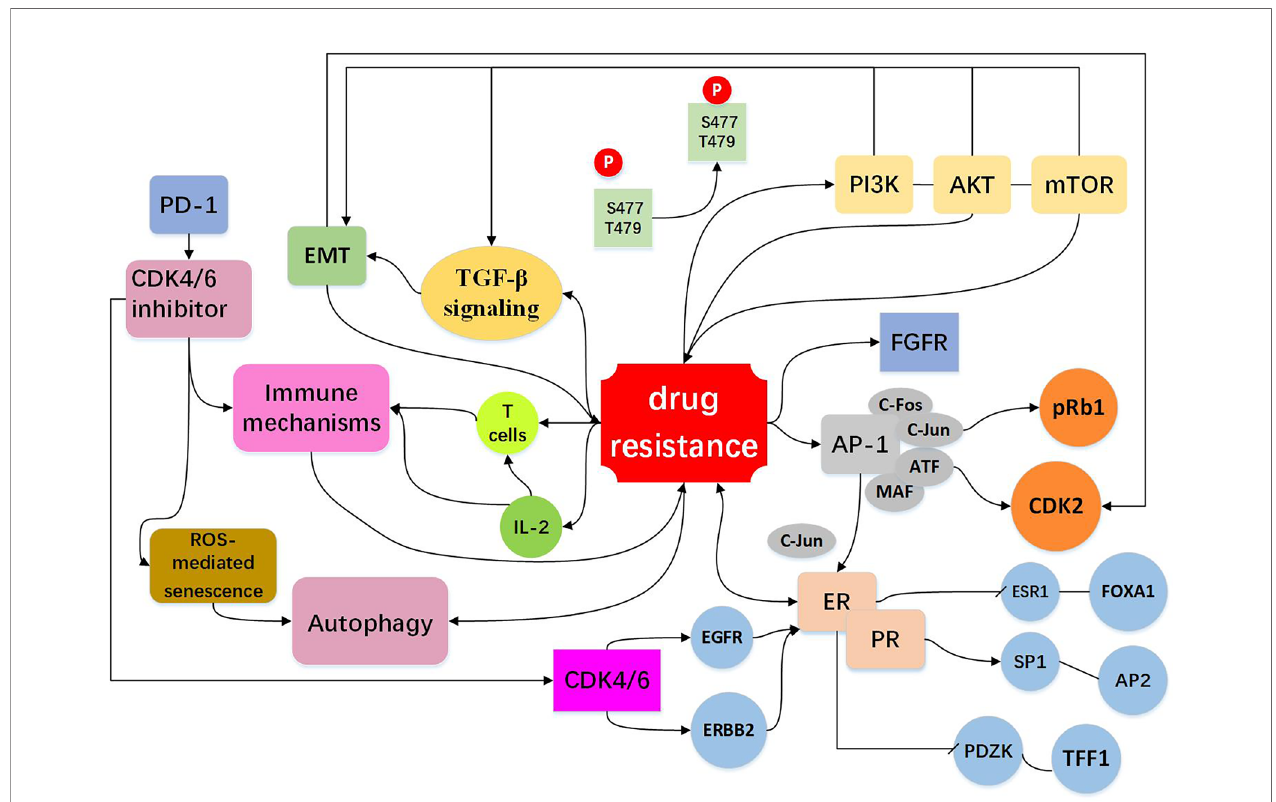
FIGURE 3 | Resistance to CDK4/6 inhibitors: Indirect Cell Cycle Mechanism Bypass pathways of the cell cycle: mTOR activation is via phosphoinositide PI3K/AKT signaling. The PI3K/AKT/mTOR pathway regulate cell signal transduction, have extensive links with other bypasses, for example EMT and TGF- b pathway (15, 41, 68 – 74). High expression of AP-1 (75 – 78), FGFR ampli fi cation (79 – 82), loss of ER or PR (13, 16, 26, 72) expression drives cells to escape CDK4/6 inhibition and act as bypass pathways for the progression of the cell. Other mechanisms include EMT (10, 83 – 87), immune mechanisms (88 – 91) and autophagy directly or indirectly in fl uence drug resistance shown in the fi gure (10, 92 –